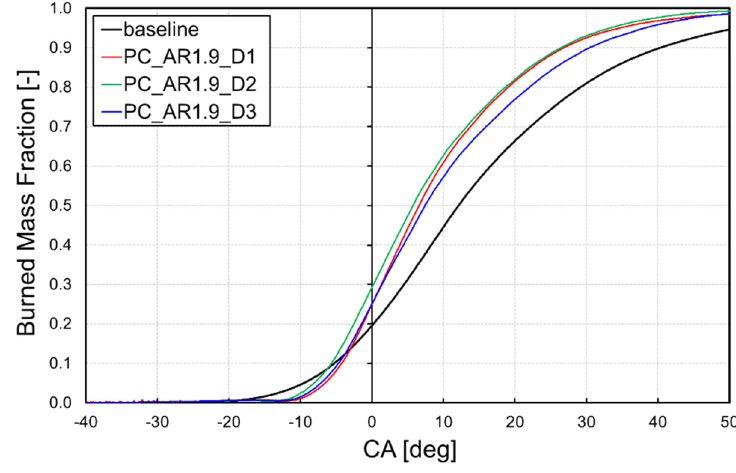
Figure 15. Influence of the orifice diameter on the burned mass fraction evolution.